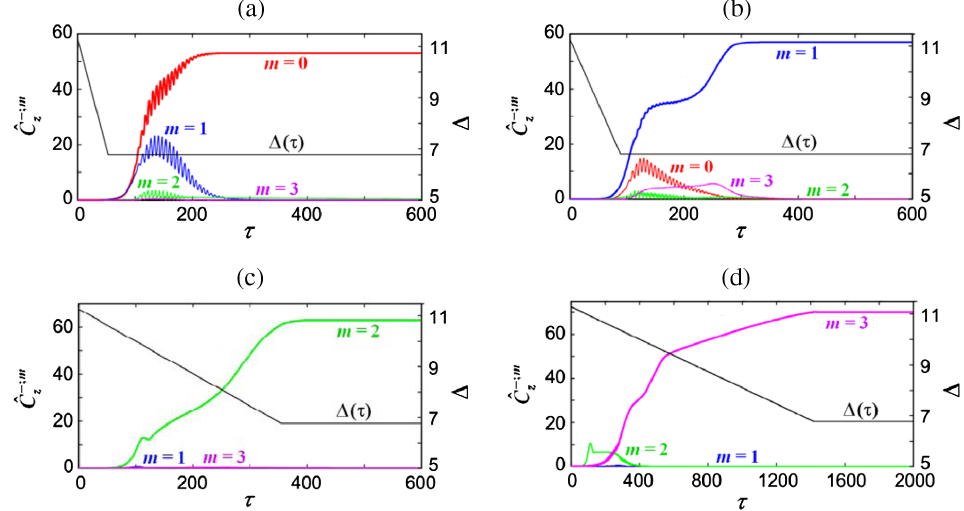
FIG. 5. Scenarios of establishment of the stationary oscillation regime at different azimuthal modes for various fronts of the voltage pulse (rise time). Temporal dependence of the modes amplitudes at the SWO output together with corresponding temporal dependence of the detuning Δ cased by the voltage growing up: (a) τ 1 . 5 , L 1 . 9 , B 0 . 2 . L z ¼ x ¼ e ¼